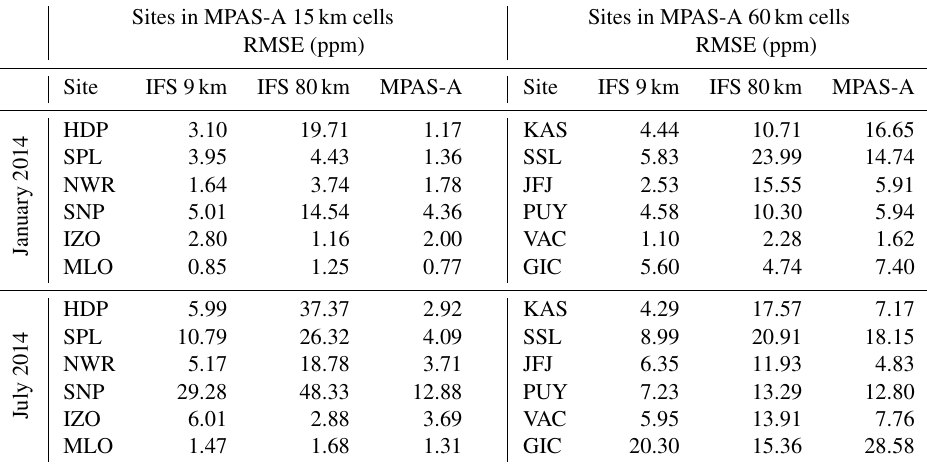
Table 6. Comparison of RMSE of hourly CO 2 between the MPAS-A 60–15km simulation and the IFS 9km and 80km simulations at 12 mountain sites (Table 4). The left half of the table is for six mountain sites located in MPAS-A’s 15km cells and the second half is for six mountain sites located in MPAS-A’s 60km cells. The top half of the table is for January 2014 and the bottom half is for July